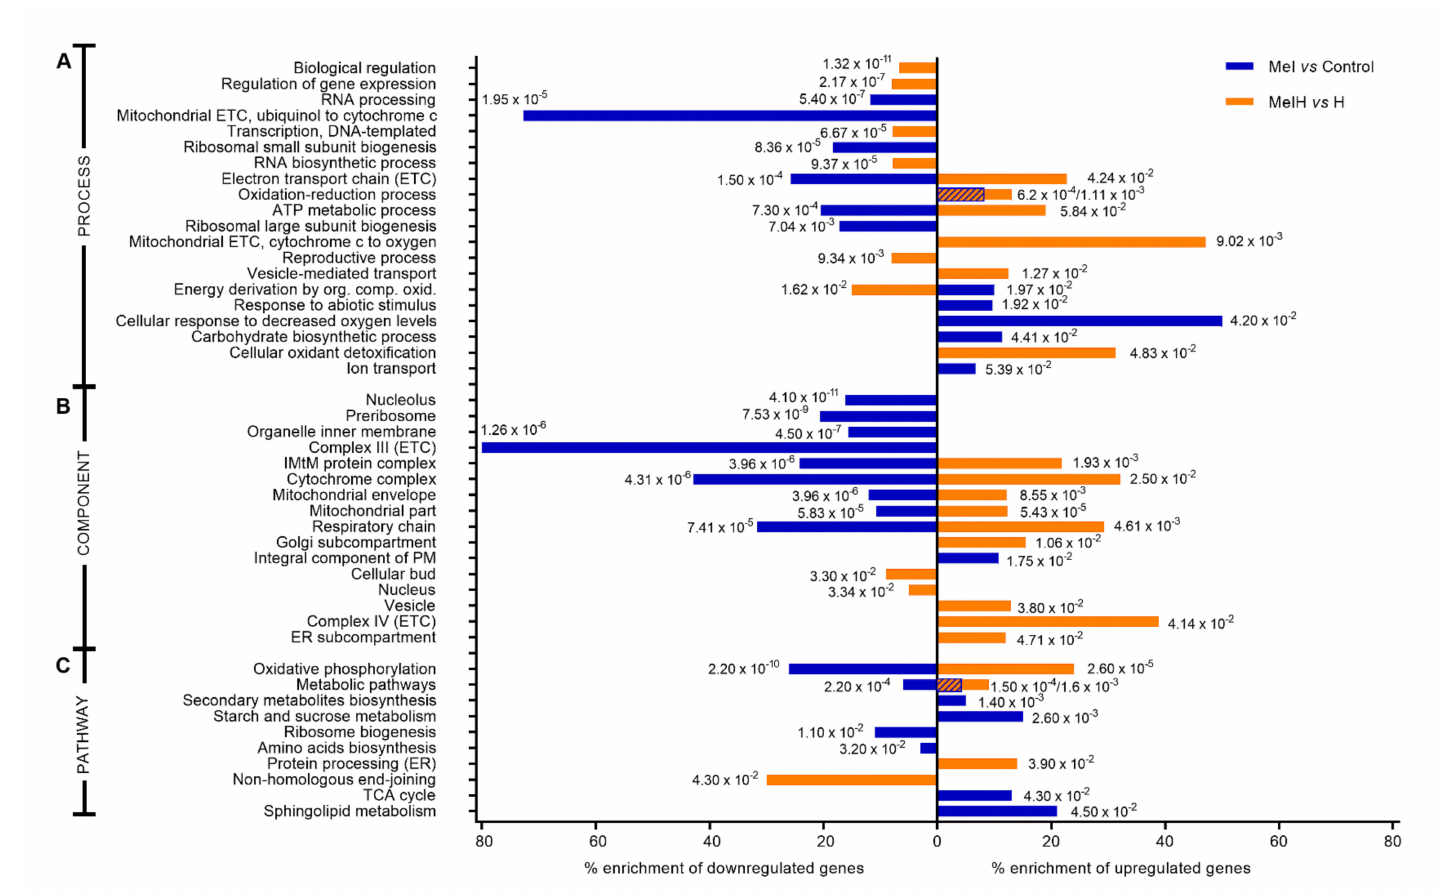
Figure 2. Categories enriched by di ff erentially expressed genes that were up- (values to the left) and down- (values to the right) regulated (1 ≤ fold change ≥ 1; p -value < 0.05) among nonstressed (blue) and stressed (orange) (2 mM H 2 O 2 ) cells in the absence or presence of melatonin (5 µ M). Percentages of enrichment are calculated as the ratio of the number of up- or downregulated genes in relation to the total number of genes involved in each molecular function or pathway in S. cerevisiae . The numbers correspond to the p -values. When two p -values are presented, the left one corresponds to Mel vs. Control and the right to MelH vs. H. ( A ) Biological process function enrichment from Gene Ontology (GO) analysis, ( B ) cellular components enriched according to GO analysis, ( C ) pathway enrichment analyzed with the DAVID tool. Abbreviations: ETC, electron transport chain; ER, endoplasmic reticulum; TCA, citrate cycle, IMtM, inner mitochondrial